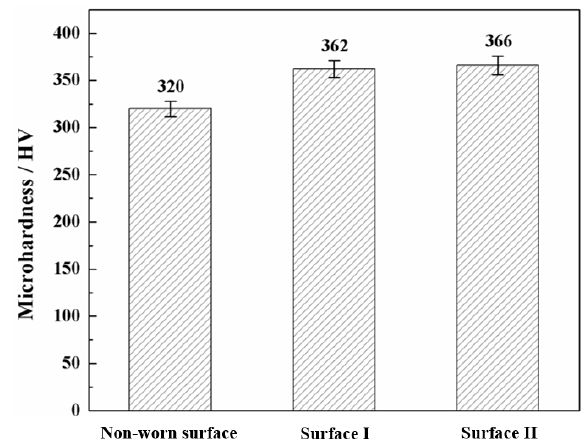
Figure 10. Comparison results of surface microhardness.